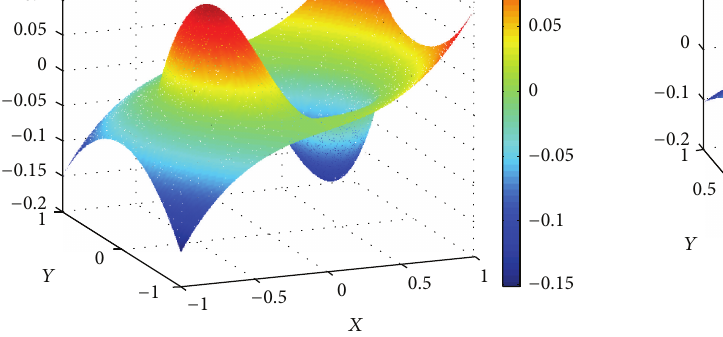
Figure 7: 𝑥 -component, 𝜇 − = 1, 𝜇 + = 10, 𝜆 = 5𝜇 elliptical interface.